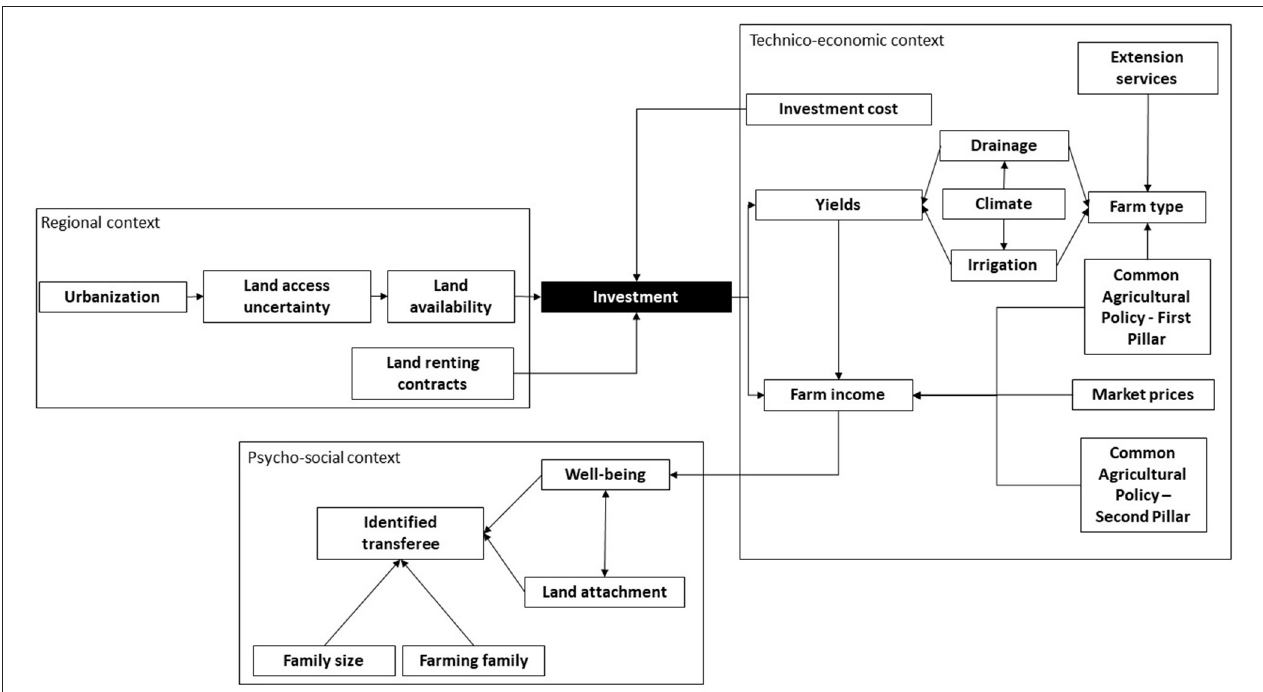
FIGURE 1 | The investment decision-making mental model of Interviewee F-CC3 (Source: adapted from Akimowicz et al., 2020).